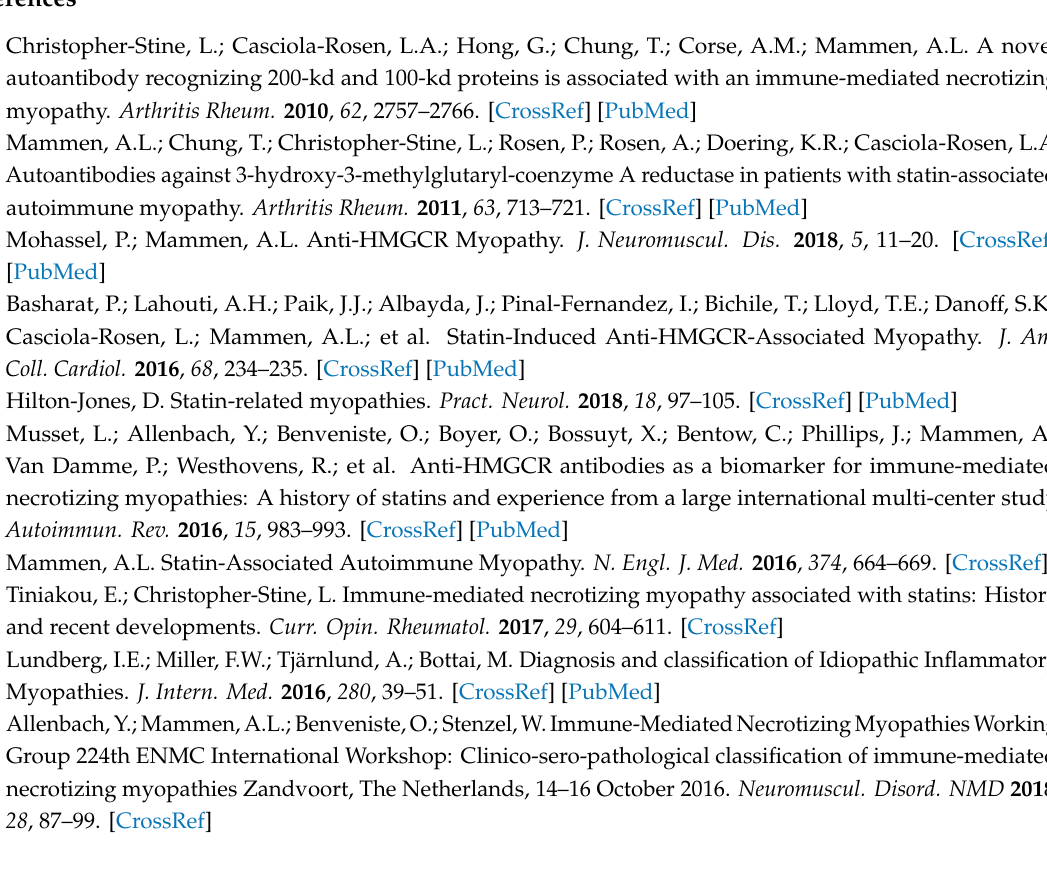
Table S1: Characteristics of the relapsed patients ( n =